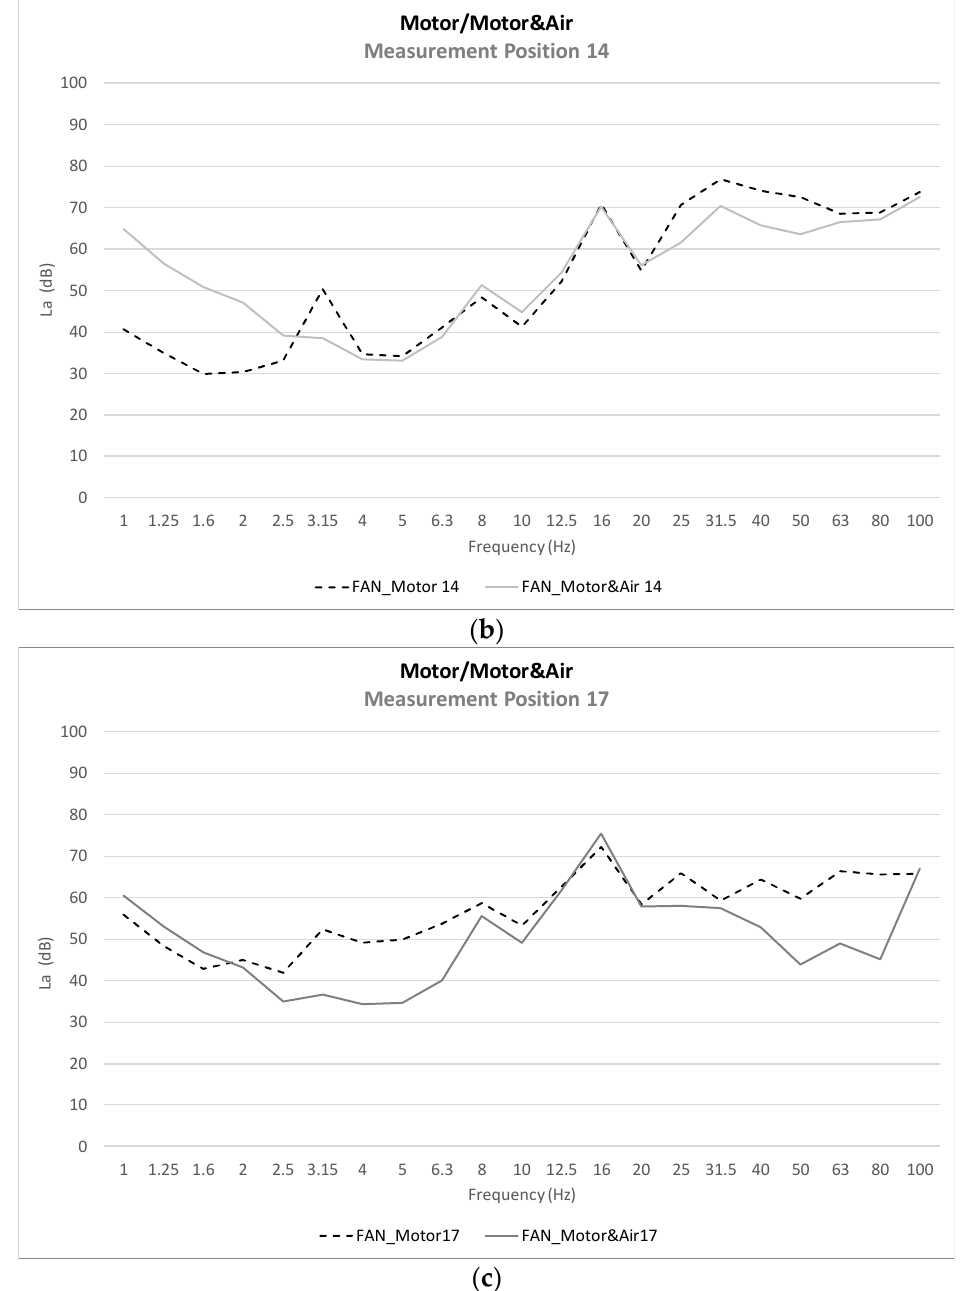
Figure 7. Average La (dB) levels comparative. FAN_Motor&Air Scenario. ( a ) Position 11; ( b ) Position 14; ( c ) Position 17.